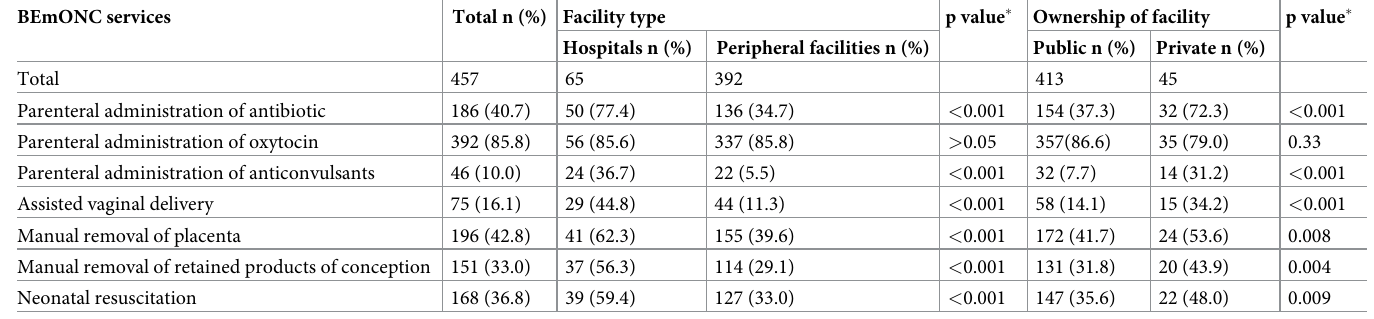
Table 2. BEmONC services availability by type of health facility.